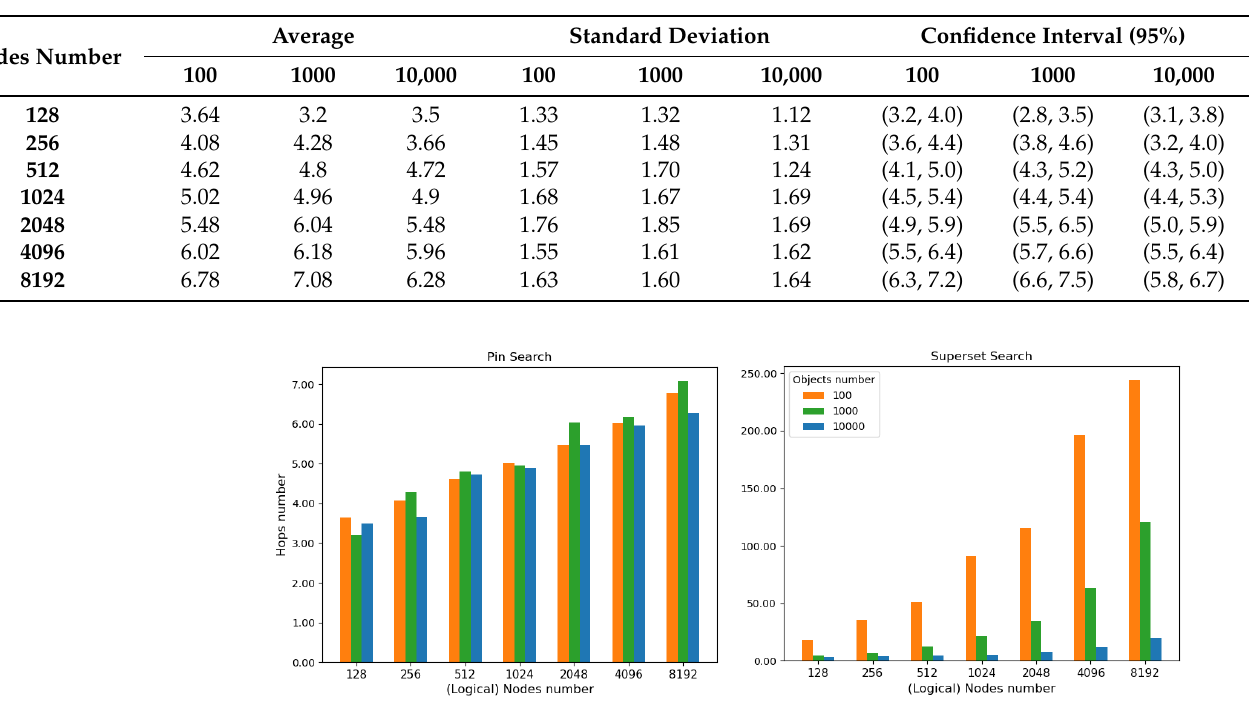
Figure 9. Number of hops on average for the Pin Search ( left ) and Superset Search ( right